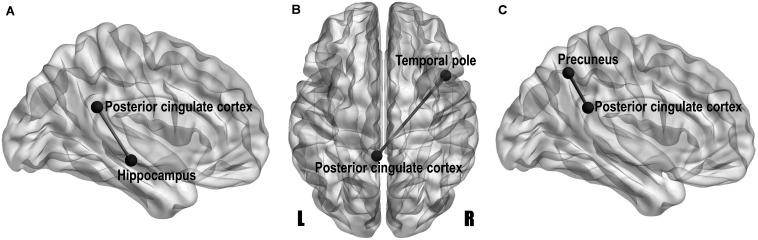
Network-style maps of significant differences in structural covariance within the default mode network between the HCs and patients with MCI (A), between the HCs and patients with type 2 diabetes mellitus and MCI (T2DM-MCI) (B), and between the MCI and T2DM-MCI groups (C). Differences in correlation coefficients for gray matter volume are presented on a standard translucent brain. Bonferroni-corrected p-value < 0.05.